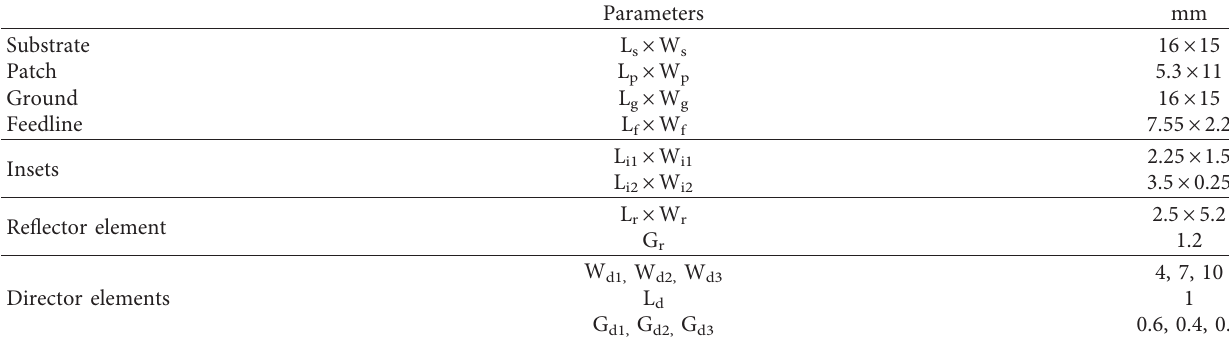
Figure 1: Geometry of single patch element with Yagi elements. Table 1: Dimensions of the single patch